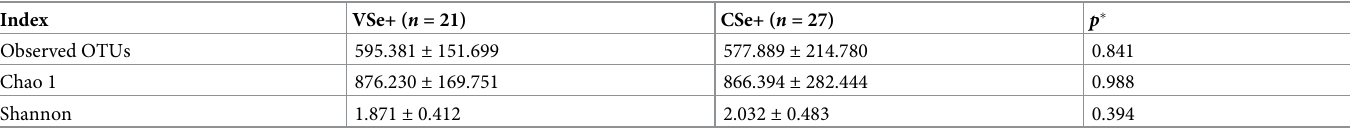
Shannon Values are presented in mean ± SD; VSe+: Vaginally born, secretor; CSe+: Cesarean born, secretor. � p-values were adjusted for age at inclusion using ANCOVA (analysis of